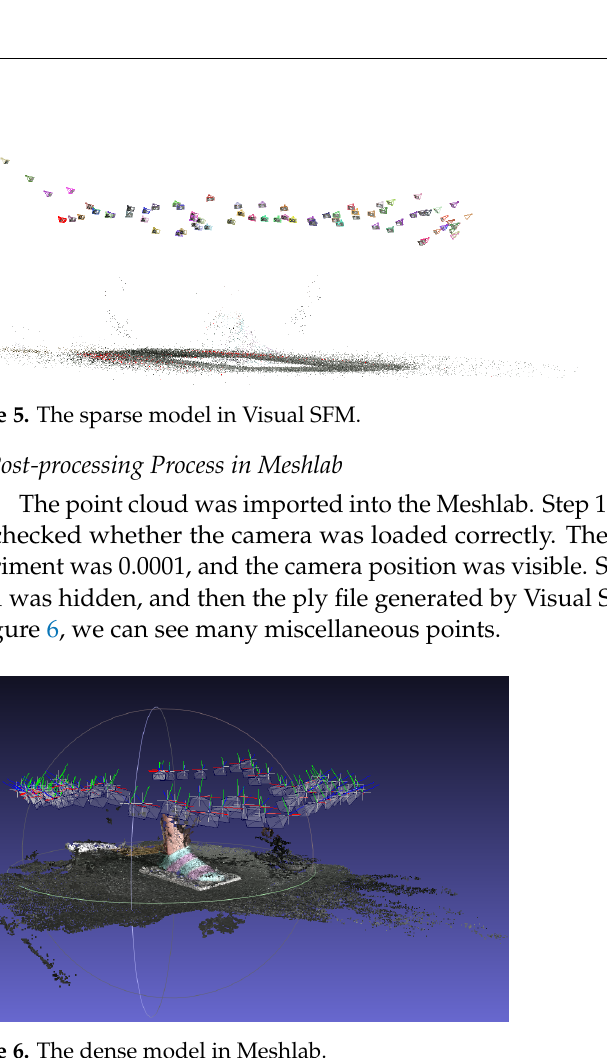
Figure 6. The dense model in